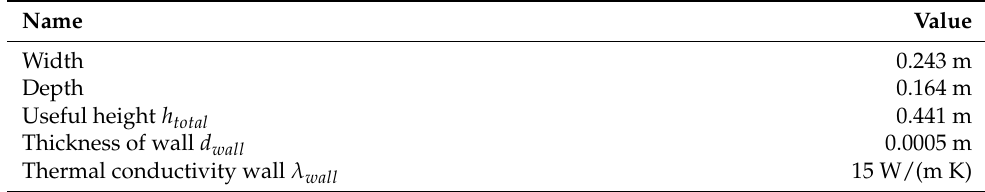
Table A1. Geometry heat exchanger.